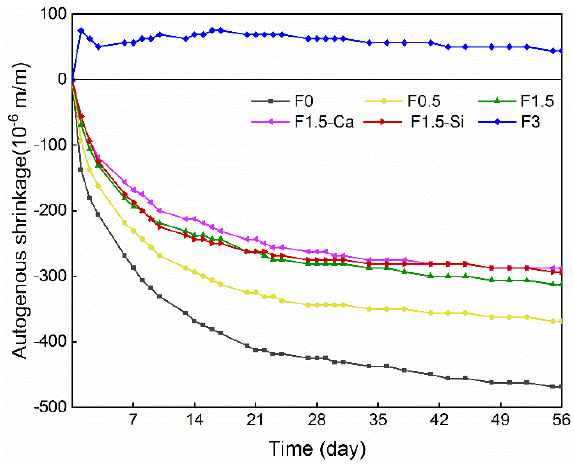
Figure 11. Autogenous shrinkage of LWAC with coir fibers of various contents and different treat- ments measured in 56 days.